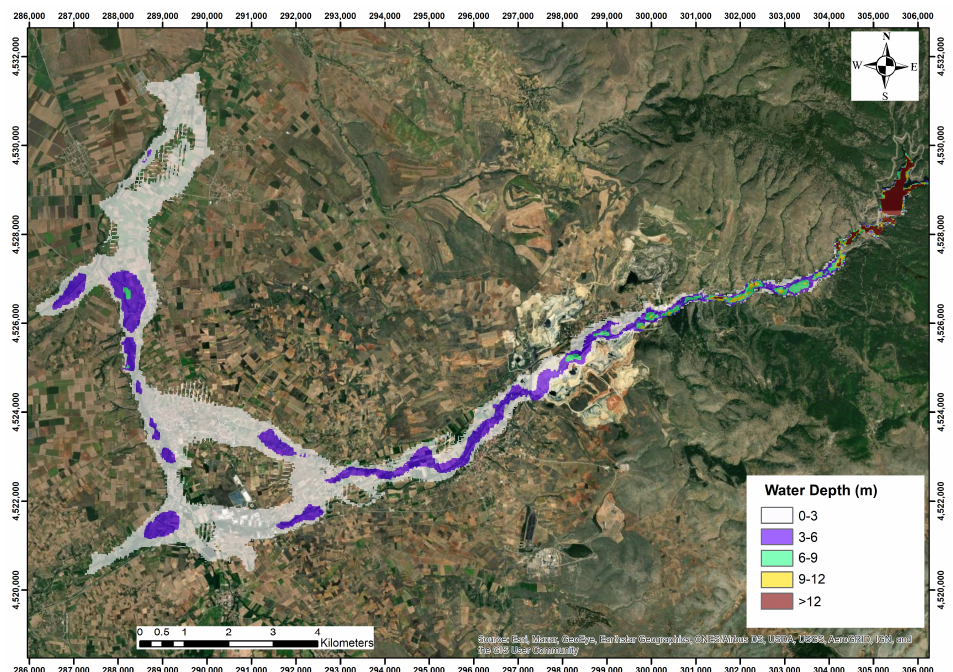
Figure 13. Maximum water depth and boundaries of inundated area in the case of overtopping dam failure.